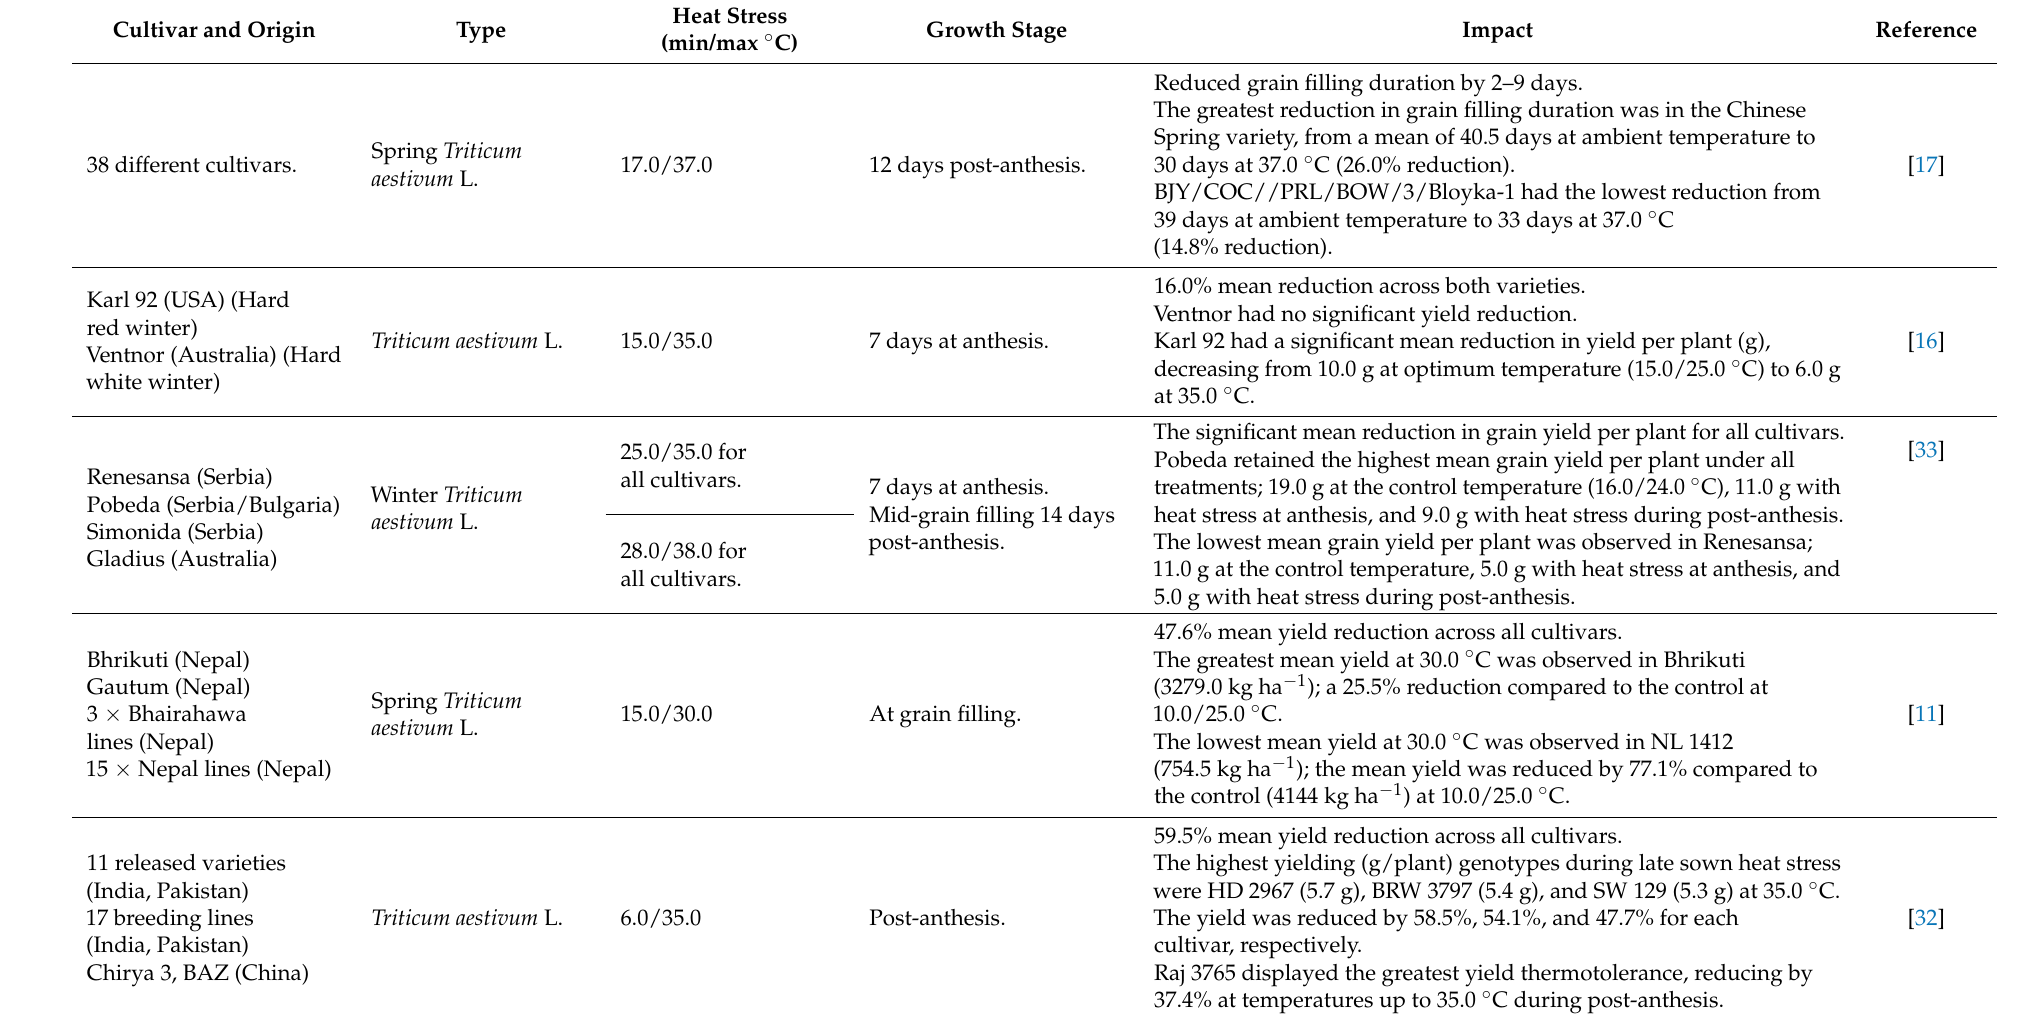
Table 1. The effect of heat stress on wheat grain yield at anthesis and